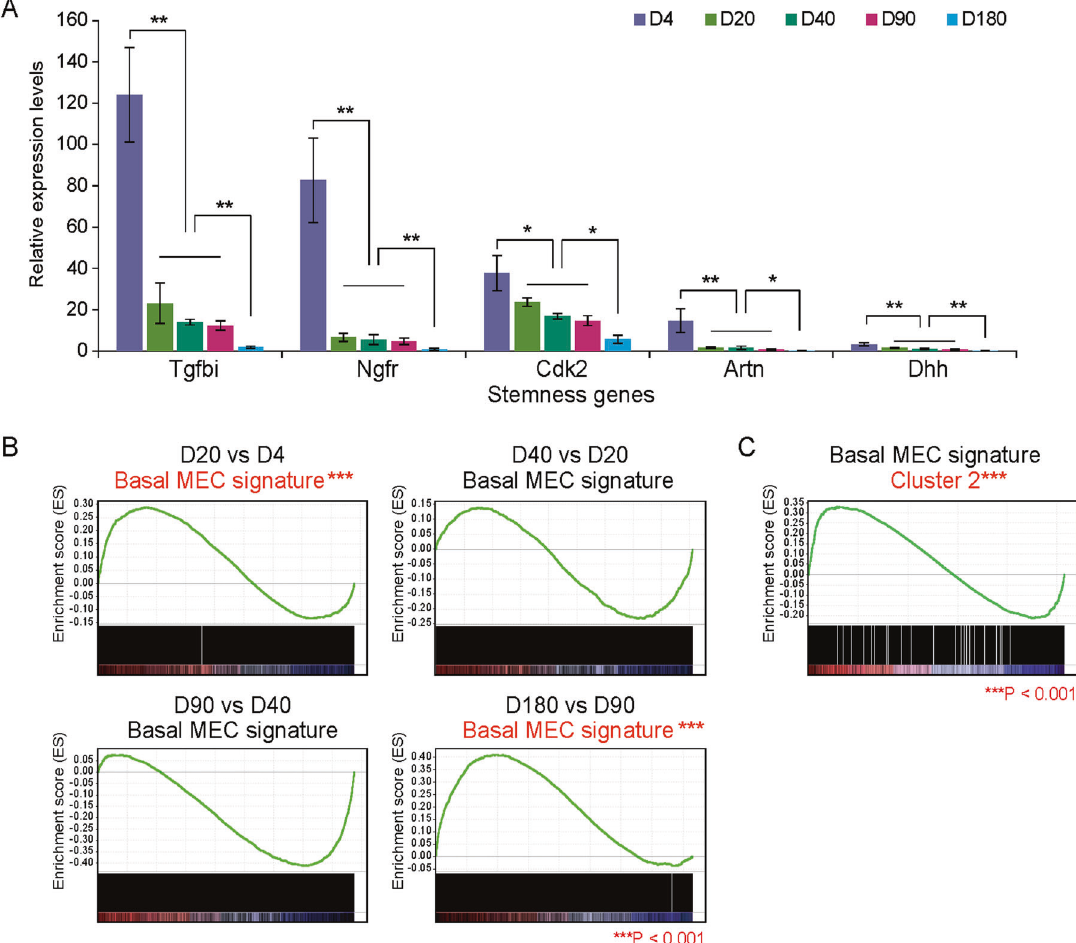
Fig. 5 Stem cell-related gene expression signature. A Expression pattern of the representative stemness-related genes including TGFBI, NGFR, CDK2, ARTN, and DHH indicating the highest levels at D4 of the neonatal age and the lowest levels at the D180 of old age. B GSEA analysis revealed that DEGs in D20 vs. D4 and D180 vs. D90 are signi fi cantly enriched in a stemness gene signature derived from GSE116385. C GSEA analysis showed upregulation of DEGs in Cluster 2 in basal MECs vs.